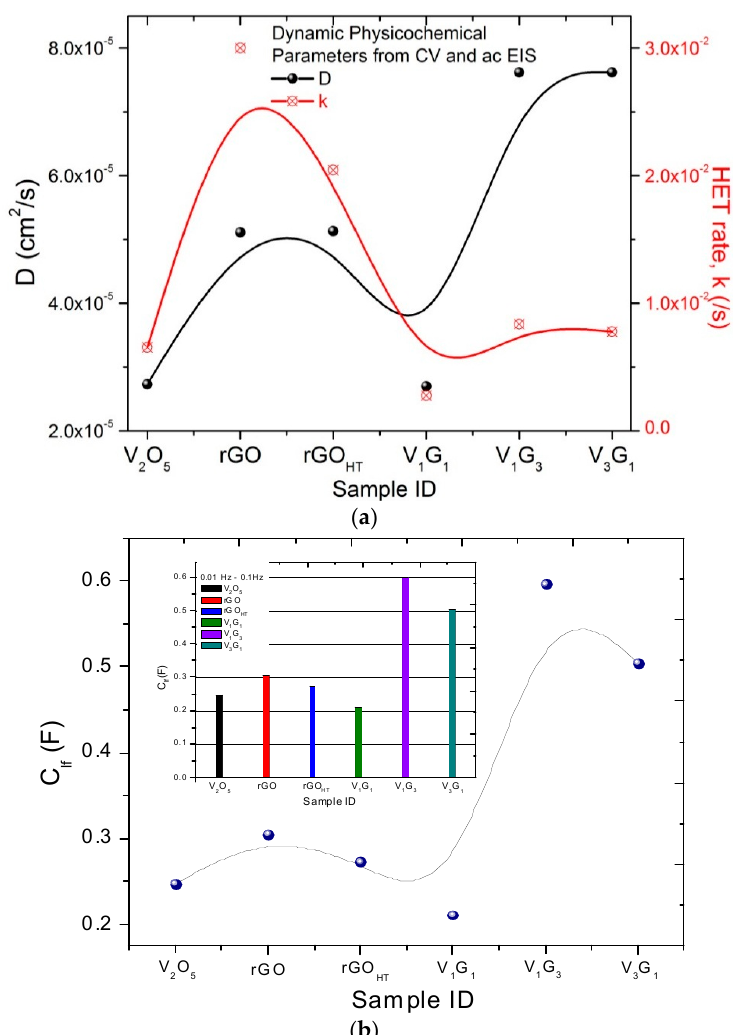
Figure 7. Variation of ( a ) D and k and ( b ) low frequency capacitance C lf . The inset shows C lf as a histogram.